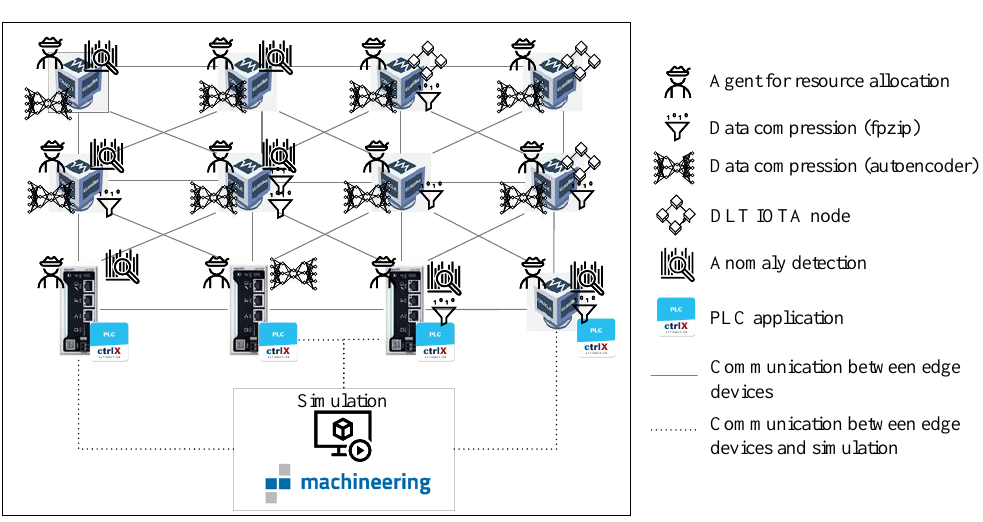
Figure 10. Illustration of the overall system in evaluation of the middleware